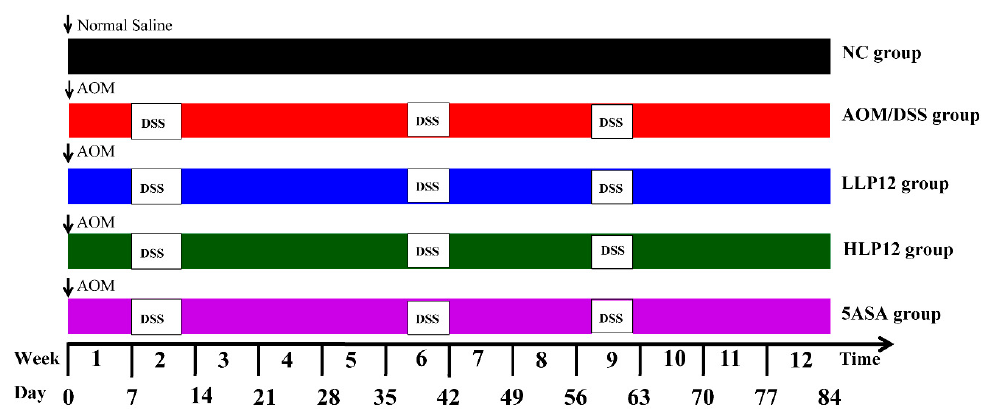
Figure 1. Experimental design of AOM/DSS-treated colon cancer models in the C57BL/6 mice ( L. plantarum -12/5ASA, intragastric administration; AOM, intraperitoneal injection; DSS, administered by drinking water).